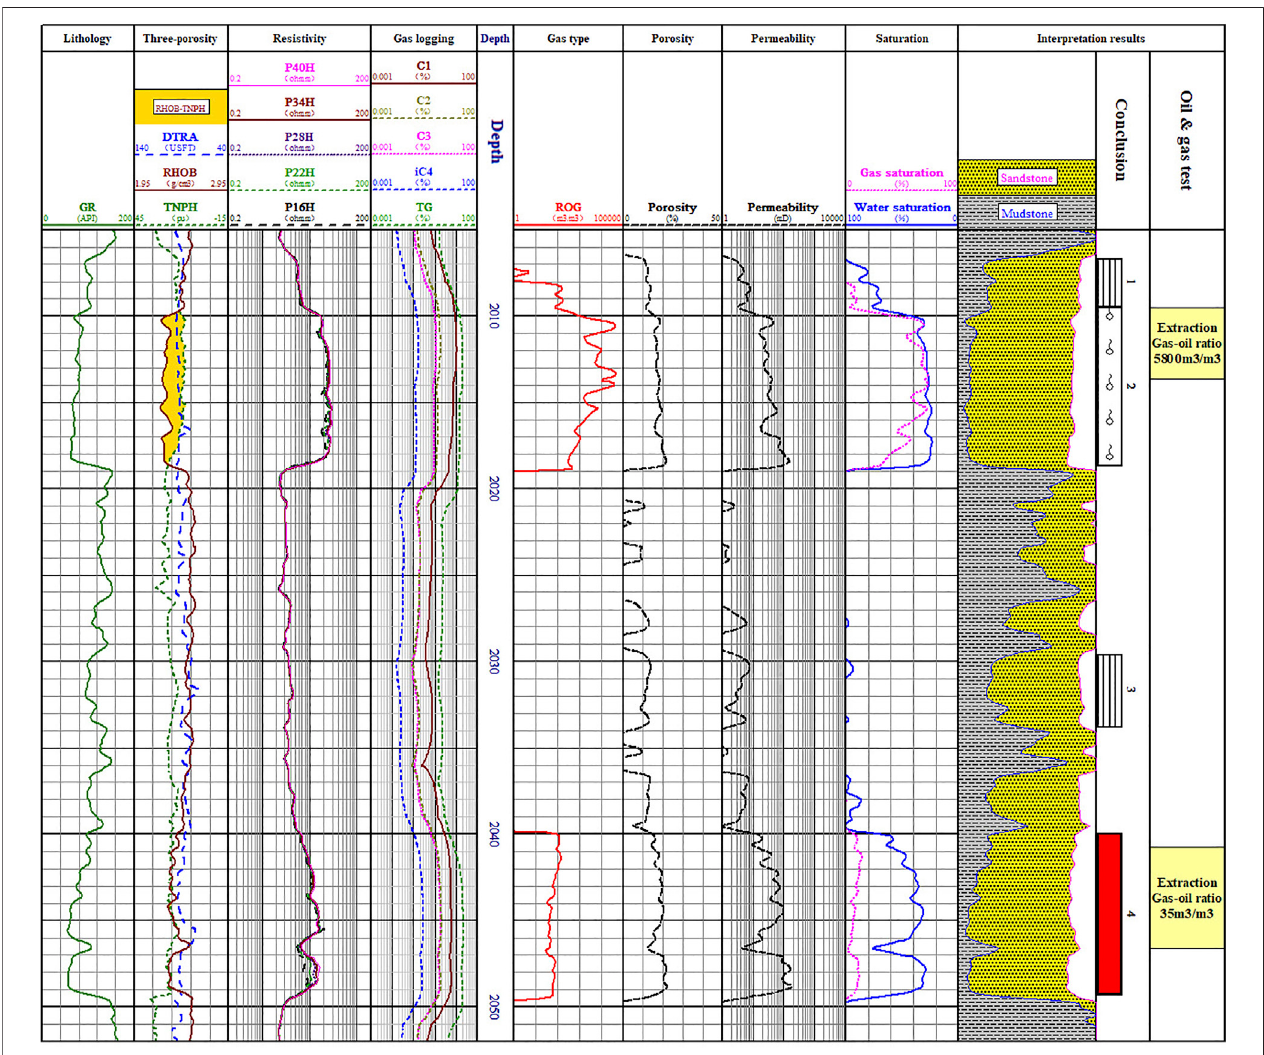
FIGURE 6 | Diagram of the logging interpretation results of well O-A1 (2005 – 2052 m). GR means the natural gamma-ray logging curve, DT means the acoustic loggingcurve,RHOBmeansthedensityloggingcurve,TNPH meanstheneutron loggingcurve,P16H-P40Hmeanstheresistivityloggingcurvewhiledrilling, C1means methane, C2 means ethane, C3 means butane, iC4 means isobutane, TGAS means total hydrocarbon, and ROG means quantitatively calculated gas – oil ratio.